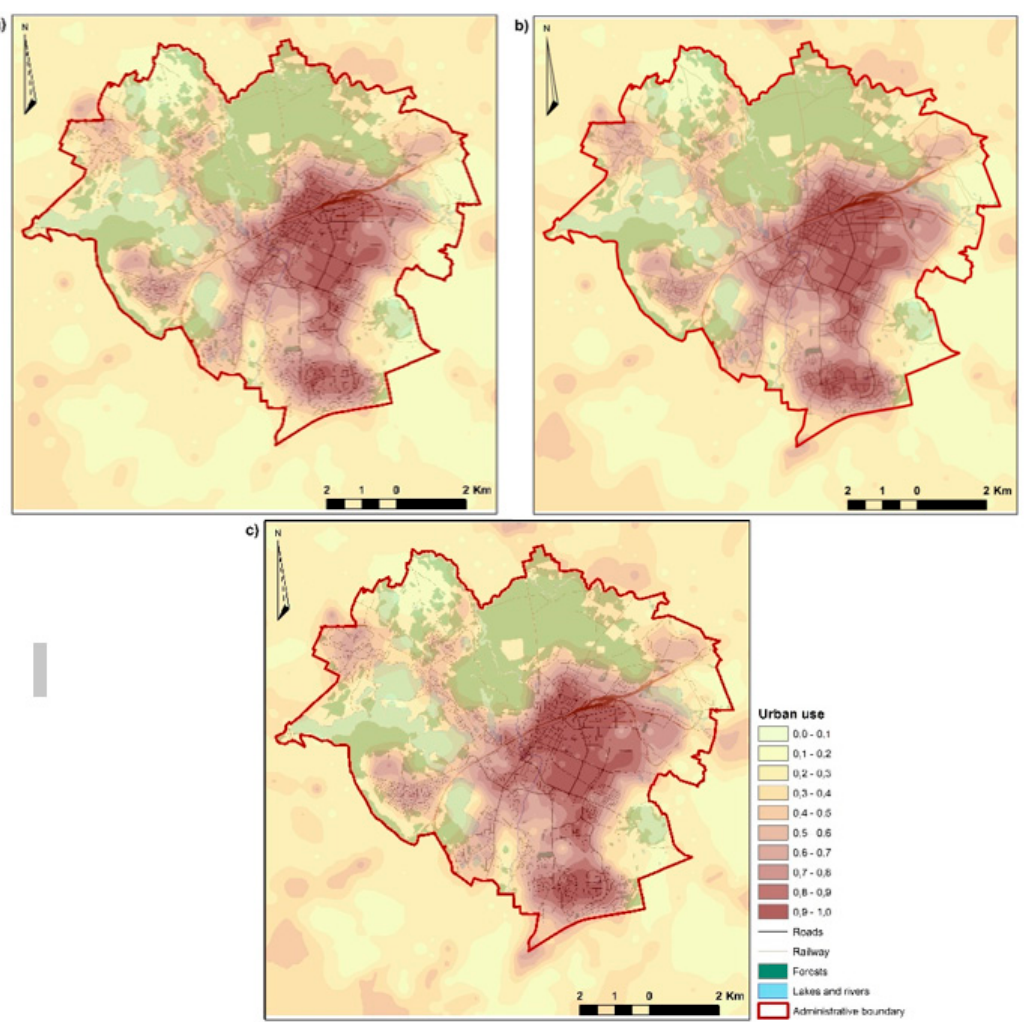
Figure 5. Urban land-use functions in the studied area expressed by the degree of membership in the interval [0.00–1.00]: ( a ) 2005; ( b ) 2010; ( c ) 2017.